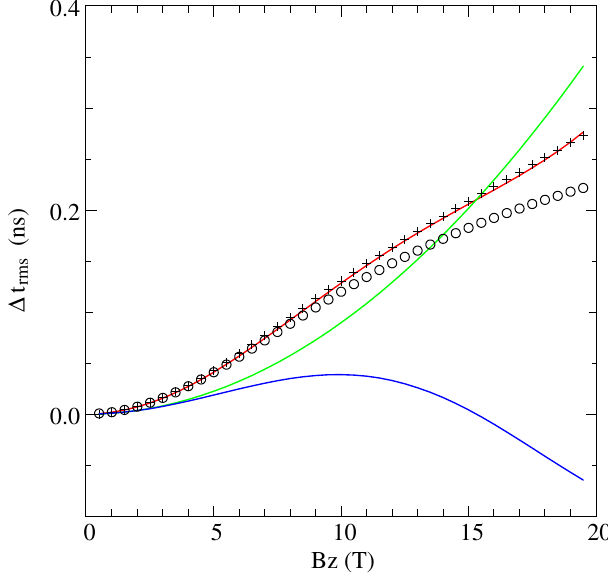
FIG. 2. Comparison of (cid:1) t rms from simulation with the analytic result. The circles show the rms time at the focal spot in the simulation for the case where the solenoid is mostly fringe. The plus signs are for the case where the solenoid is nearly hard edged. The red curve is (cid:1) t rms . The green curve is (cid:1) t 1rms and the blue is (cid:1) t 2rms . Note that beyond B z ¼ 15 T , the focal spot is inside of the solenoid, hence the negative values for (cid:1) t 2rms